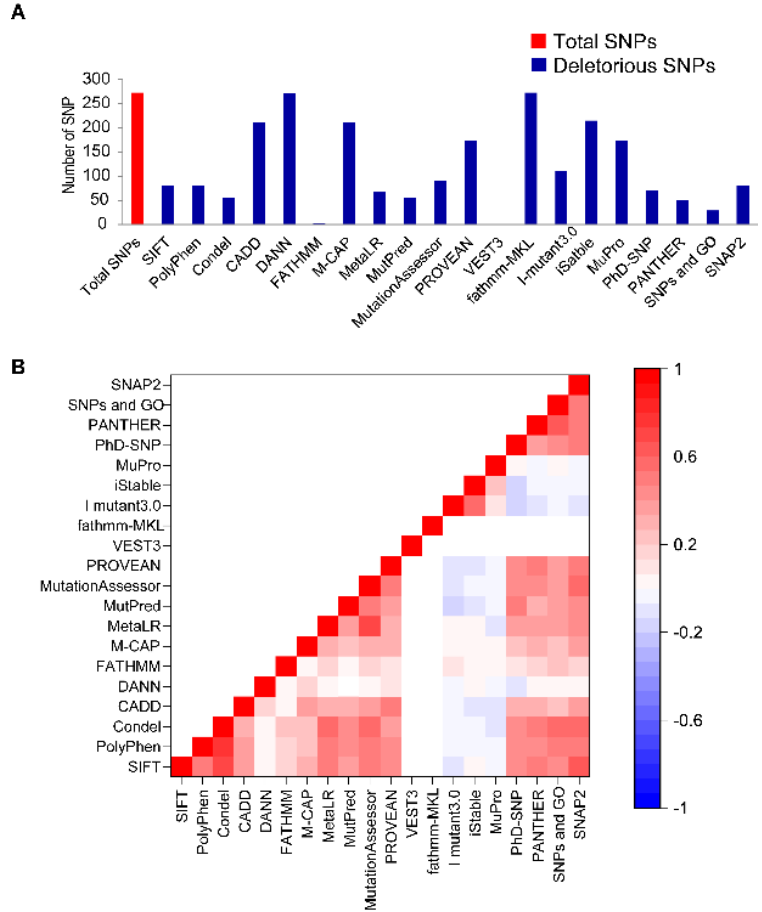
Figure 1. Different computational tools screen and predict deleterious non-synonymous SNPs (nsSNPs) in the LIS1 gene. ( A ) The bar plot represented a total number of damaging nsSNPs and ( B ) the pairwise correlation expressed by Heatmap illustration color-coded map (red, white, and blue stand for positive, neutral, and negative correlation, respectively) in the LIS1 gene by various state-of-the-art algorithms.